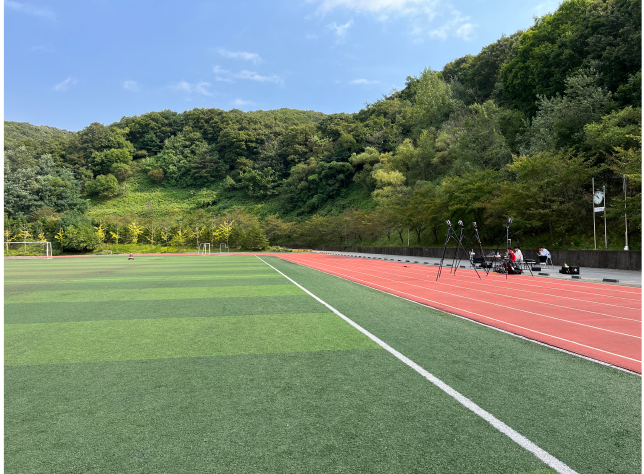
Figure 5. The rover field test at the campus